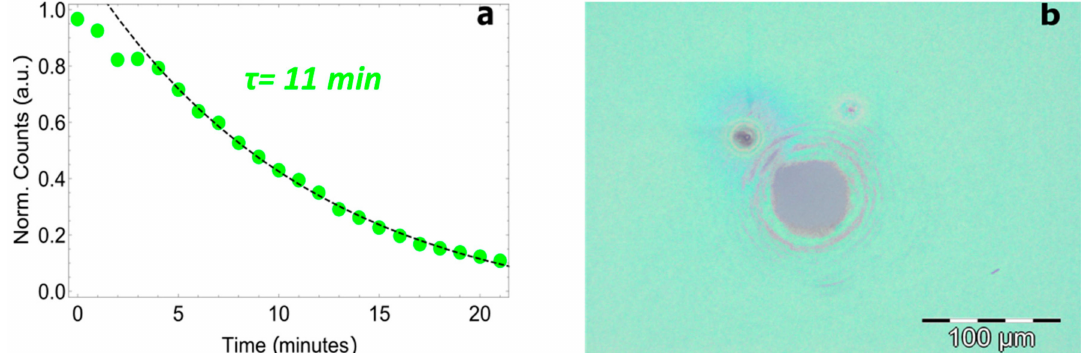
Figure 4. Normalized counts for PEAI-F polycrystalline film as a function of time ( a ). Optical image of PEAI—F polycrys- talline film ( b ) after laser